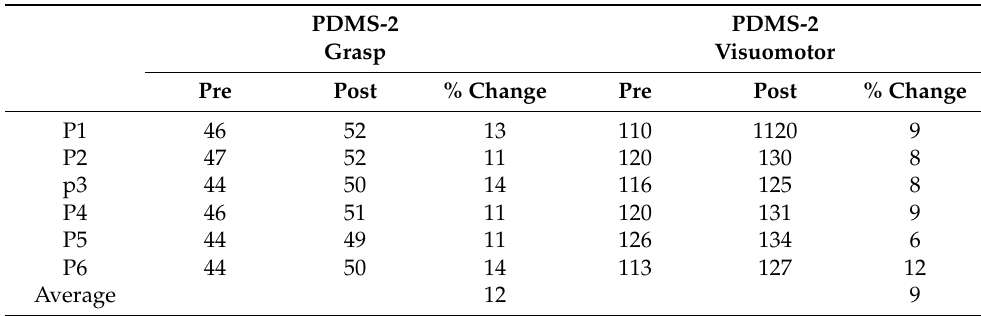
Table 2. Pre- and post-exercise test scores and percentage change for PDMS-2 grasp and visuomotor subtests for each